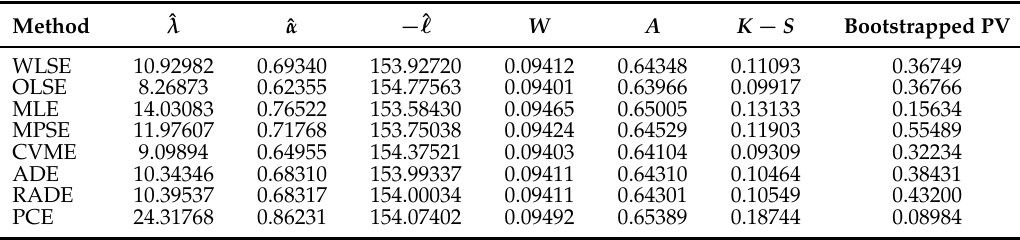
Table 14. The parameter estimates under various estimation methods, including the K − S and bootstrapped PV, for leukemia data.